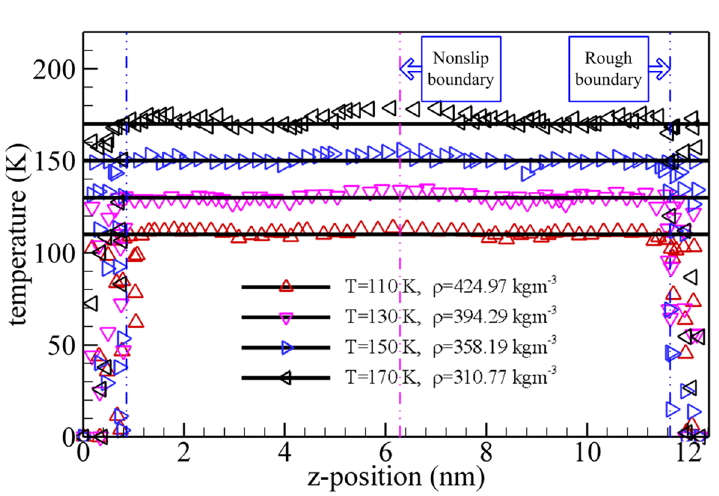
Figure 5. Total average temperature profiles from mixture boundary Poiseuille flow model via NEMSMD simulations (red squares) and theoretical value (black solid